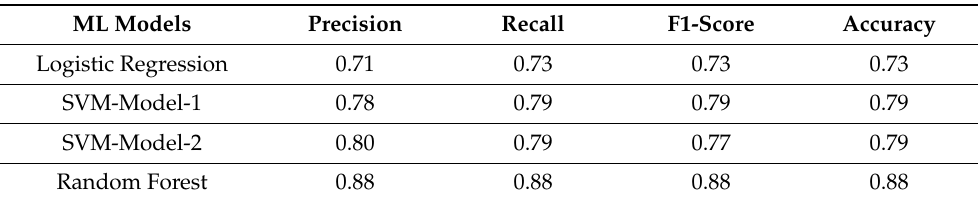
Table 4. Performance Metrics of Mg-alloy dataset on the independent test data (33 rows) using the parameters from Table 1.